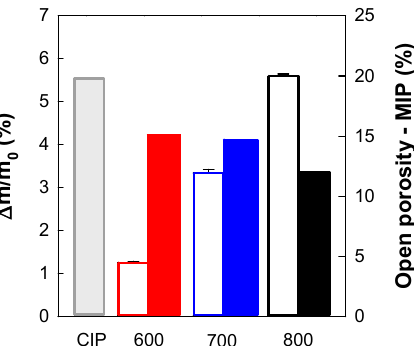
Figure 2. Correlation between the final relative weight gain and open porosity. CIP green compact was subjected to thermal oxidation at the final temperature of 600 °C (red), 700 °C (blue), or 800 °C (black). The final relative weight gain (empty bars) and open porosity (colored bars) were measured by MIP.